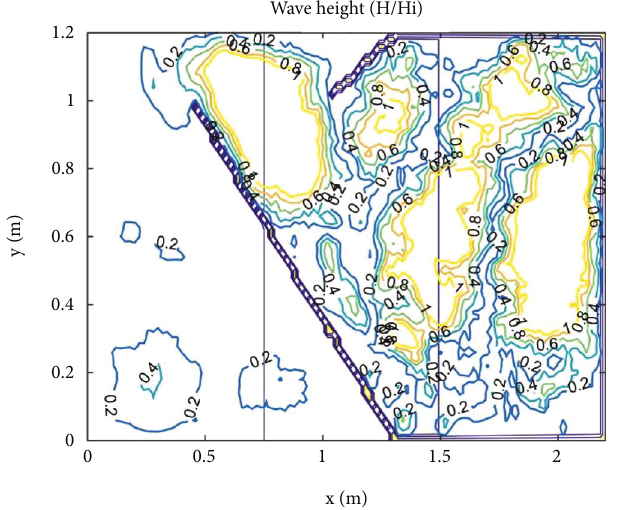
Figure 3: Results of numerical